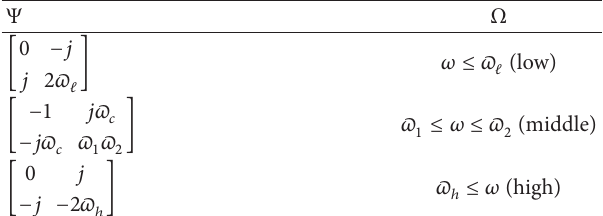
Table 2: Relation between Ψ and Ω for continuous